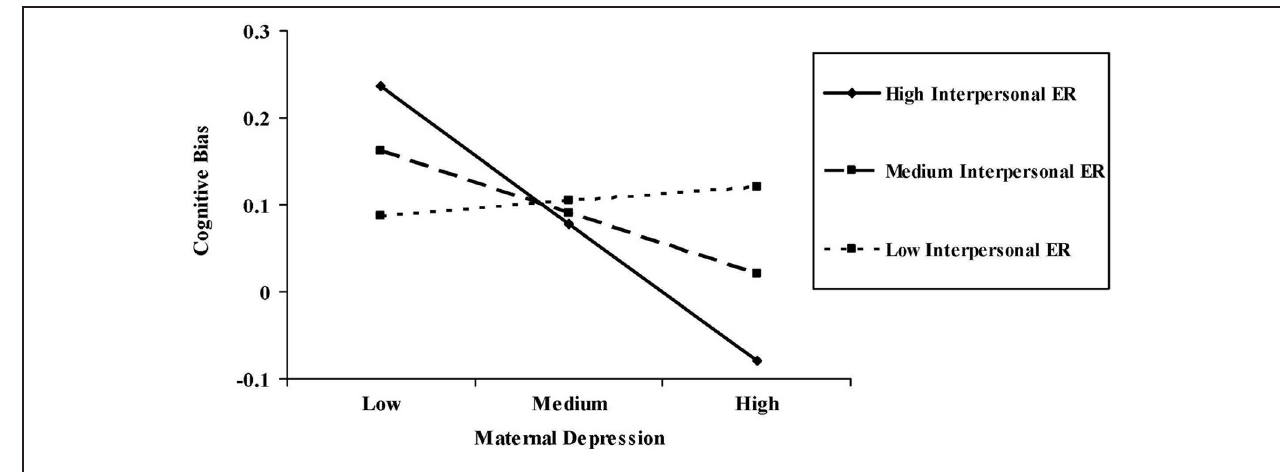
FIGURE 1 | Interaction between maternal depression and interpersonal emotional reactivity predicting youths’ cognitive bias during the processing of mother-relevant information.